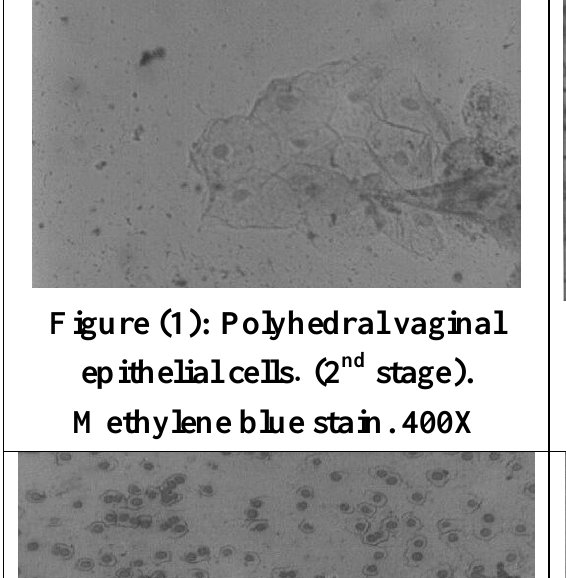
Figure (2): Keratinization of vaginal cells (arrow). (1st stage). Methylene blue stain. 400X